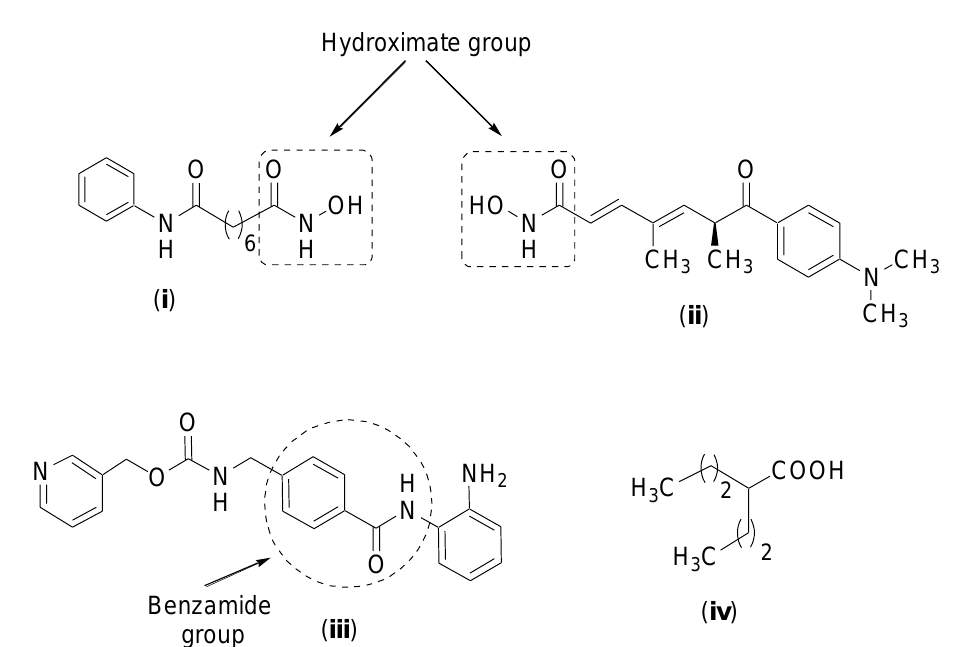
Figure 6. Structures of vorinostat ( i ), trichostatin A ( ii ), entinostat ( iii ) and valproic acid ( iv